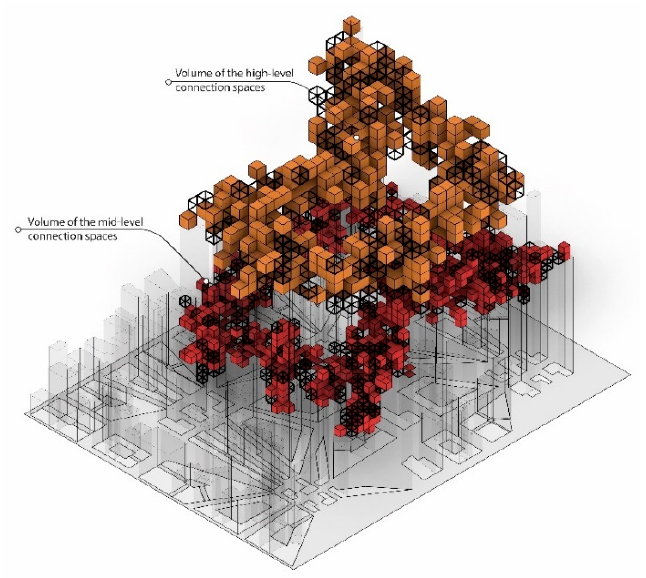
Figure 12. Fitness Function 3: Calculation of the volumetric mass of the spatial interventions throughout the superblock.